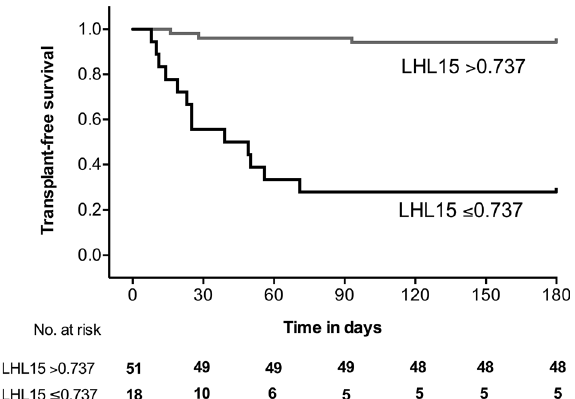
Figure 4. Survival curves stratified according to LHL15 levels according to the optimal cut-off values in patients with severe acute liver